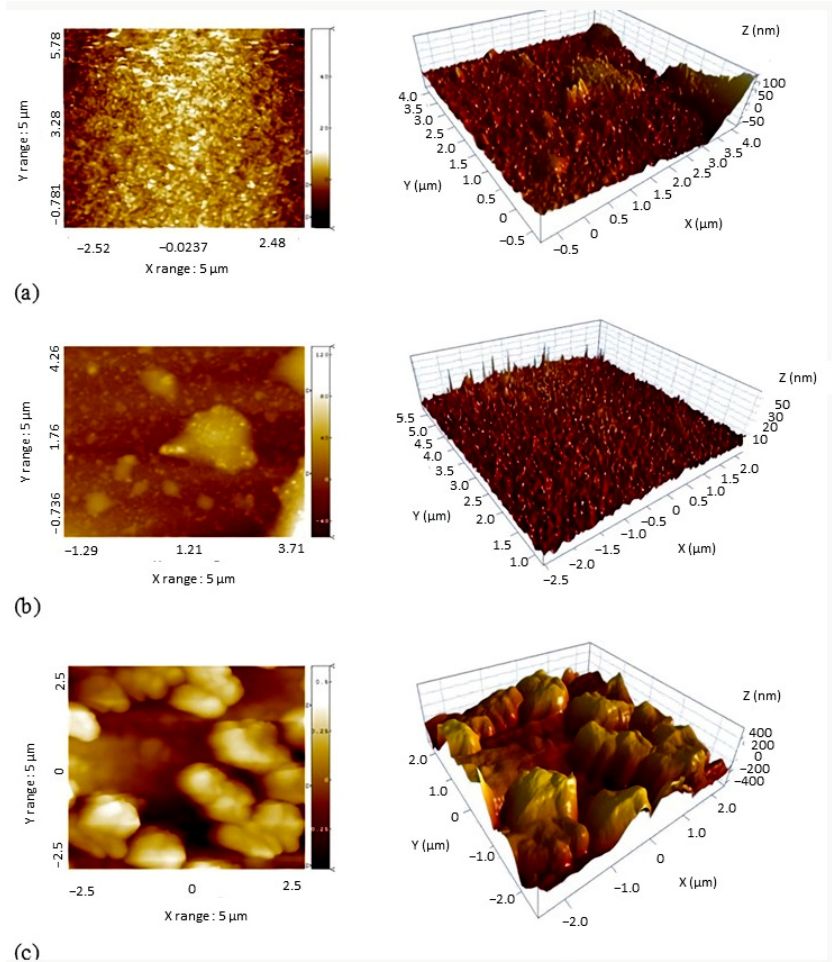
Figure 5. The AFM images of ( a ) SiO 2 -MTMS, ( b ) TiO 2 -MTMS, and ( c ) SiO 2 -TiO 2 -MTMS